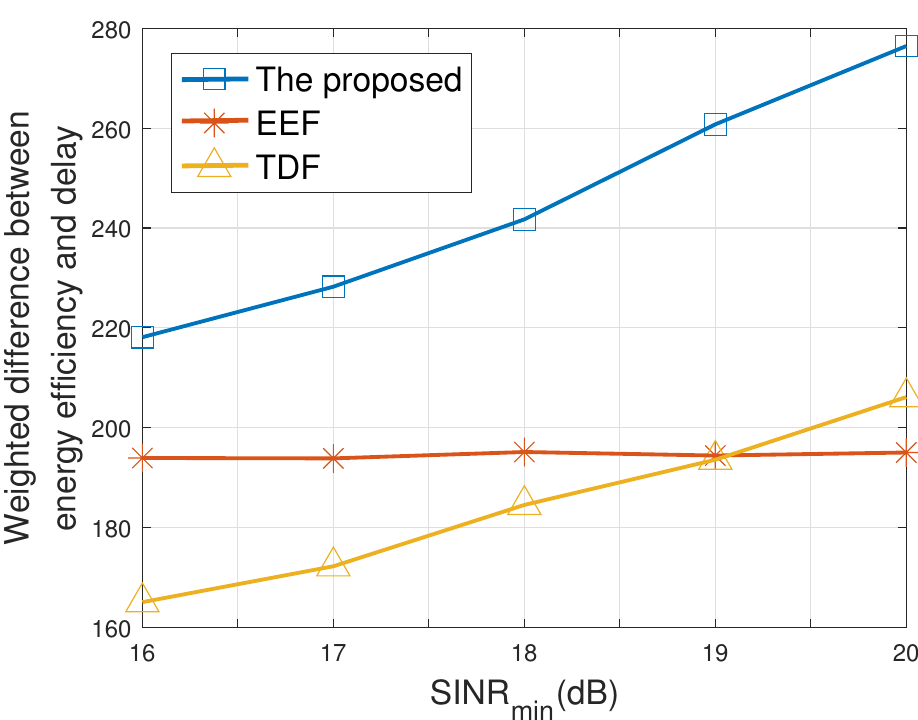
Figure 9. Weighted difference between energy efficiency and delay versus SINR min